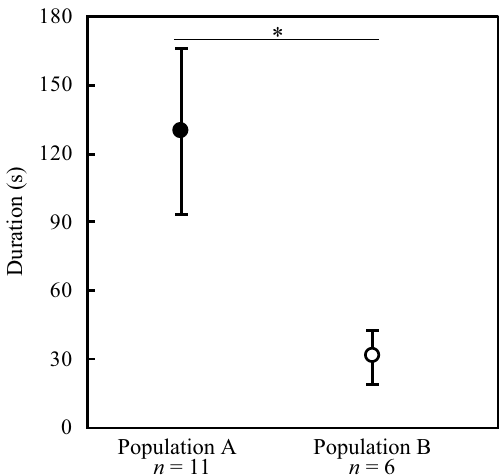
Figure 4. Duration of aggressive interaction between a soldier and a specialist predator ( A. ignipicta larva) in the two populations. The duration from when the soldier first grasped the predator until the predator tore the soldier off its body was measured in a Petri dish (population A: n = 6, population B: n = 11). The soldiers from population A (filled circle), which had a higher predator density in the wild and soldiers with larger weapons and higher aggressiveness, interacted with the predator for significantly longer than those from population B (open circle), which had a lower predator density in the wild (Welch’s t -test). Symbols and error bars indicate mean ± s.e. The asterisks indicate a significant difference between populations (* P < 0.05).